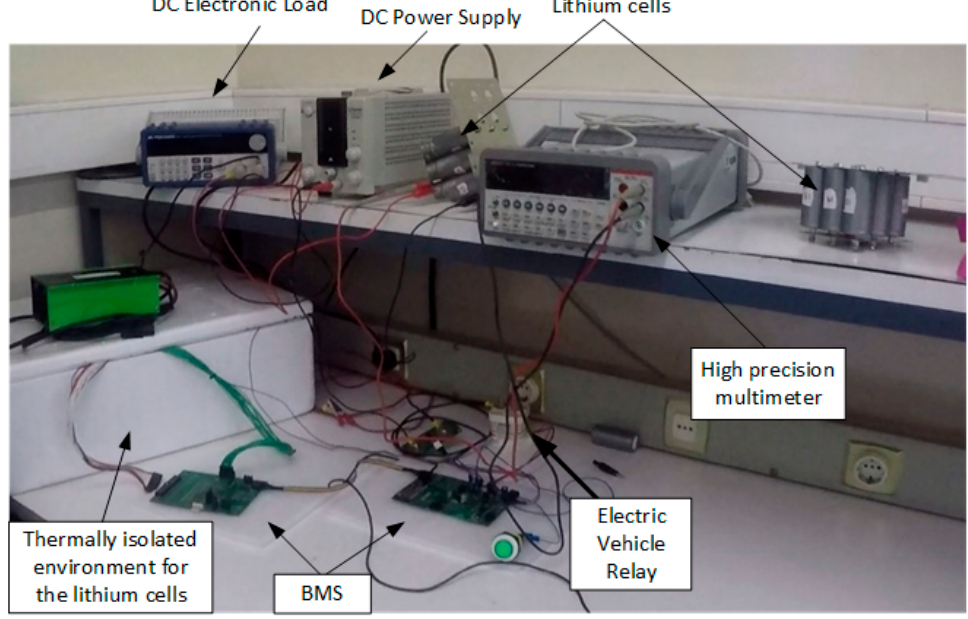
Figure 4. Test bench with BMS.